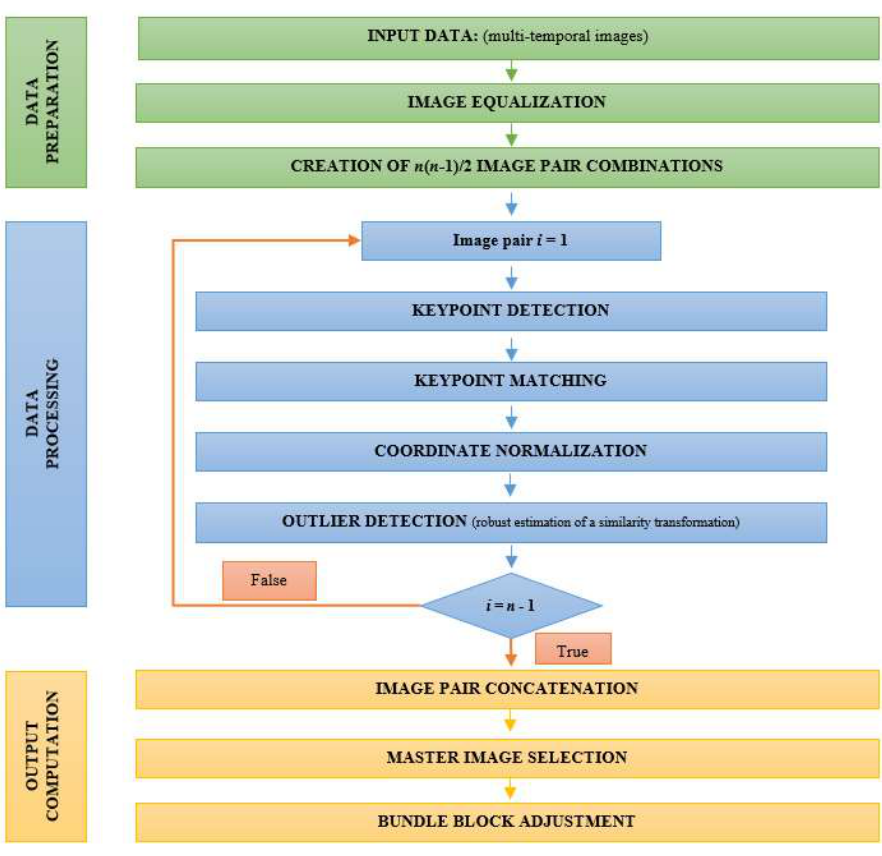
Figure 2. Flowchart of the MIRA method.